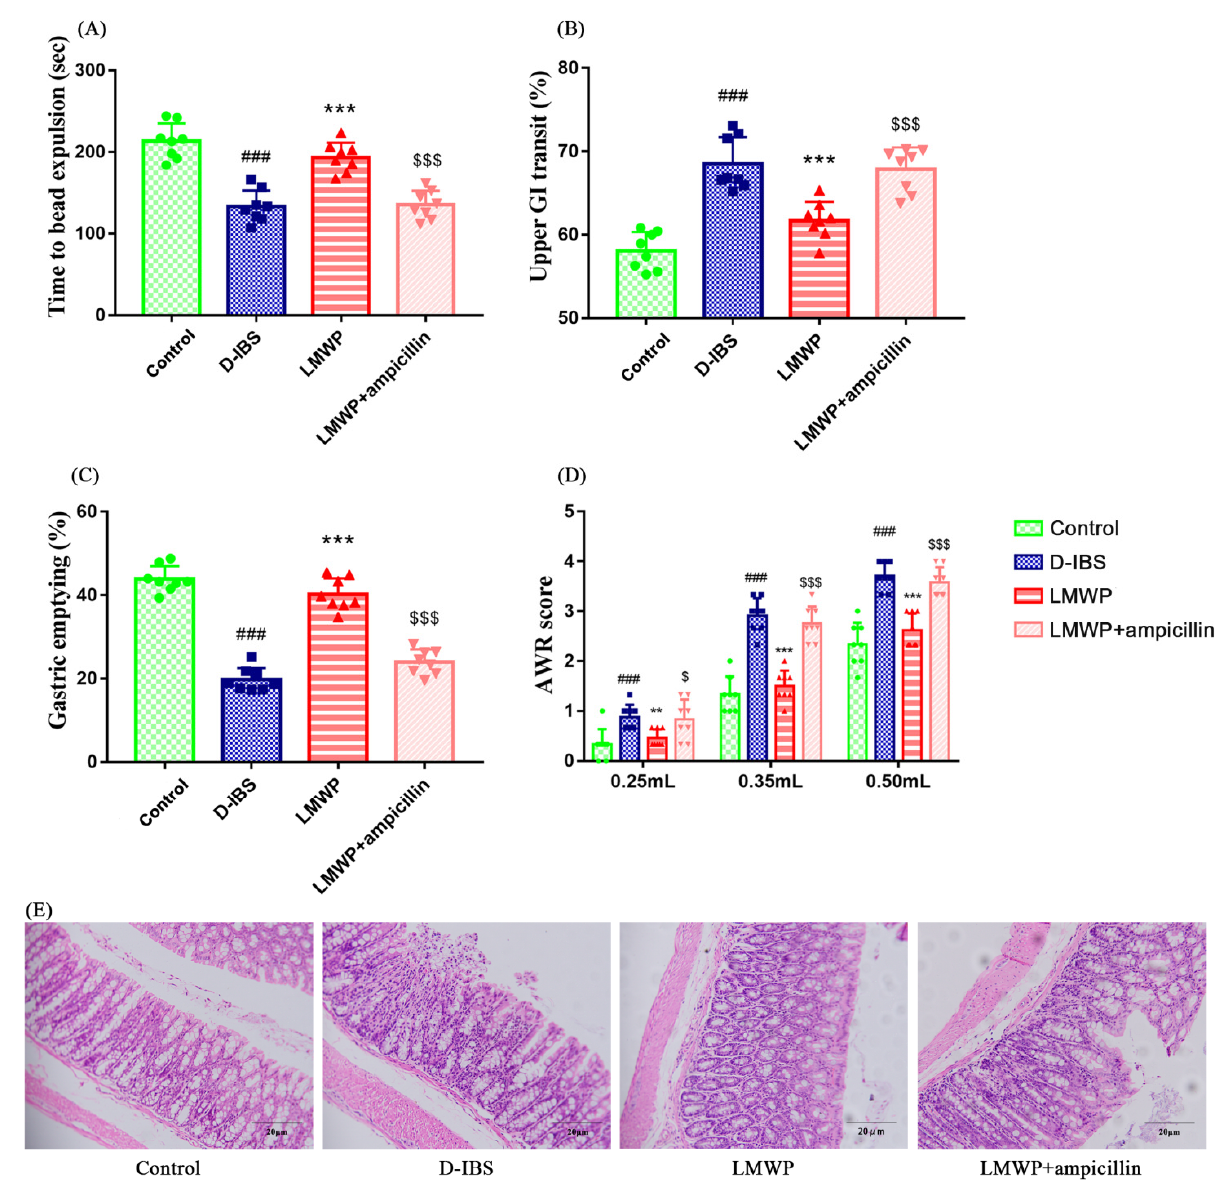
Figure 3. LMWP (S3-3) from the larvae of Musca domestica affect intestinal tract motility, visceral hypersensitivity and colonic histology in D-IBS mice. ( A ) Time to bead expulsion. ( B ) Upper gut transit. ( C ) Gastric emptying. ( D ) AWR scores. ( E ) Morphology found in the colon. Values are presented as means ± SD ( n = 8). ### p < 0.001 compared with Control, ** p < 0.01 and *** p < 0.001 compared with D-IBS, $ p < 0.05 and $$$ p < 0.001 compared with LMWP (S3-3) from the larvae of Musca domestica .